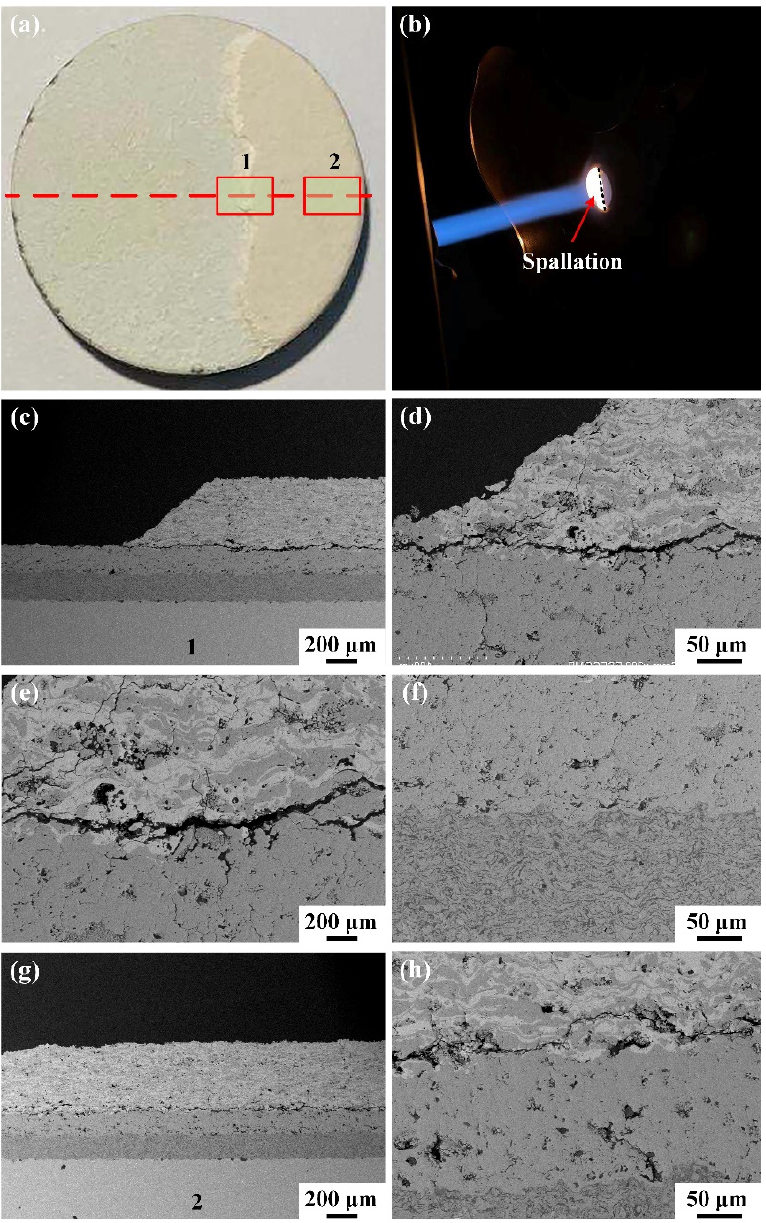
Figure 7. Macroscopic morphologies of the GZ/YSZ coating ( a ) after thermal shock and ( b ) during thermal shock, and cross-sectional morphologies of ( c – f ) area 1 and ( g , h ) area 2.